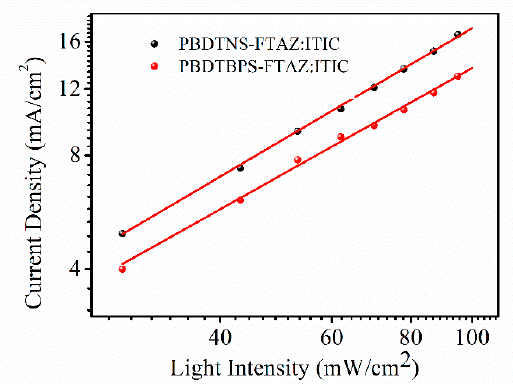
Figure 6. The curve of current density versus incident light intensity.